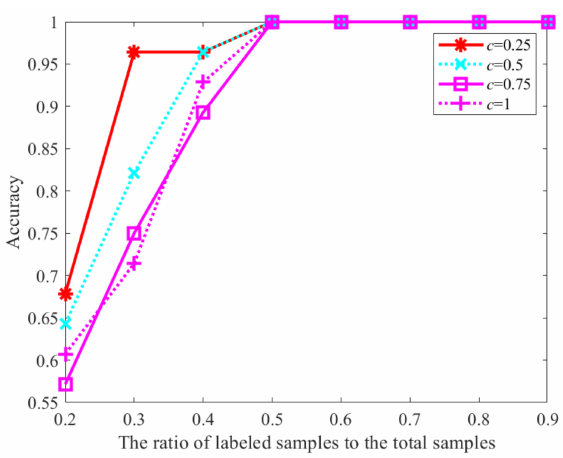
Figure 6. The accuracy of CFM-HTD with different c under different ratios of labeled